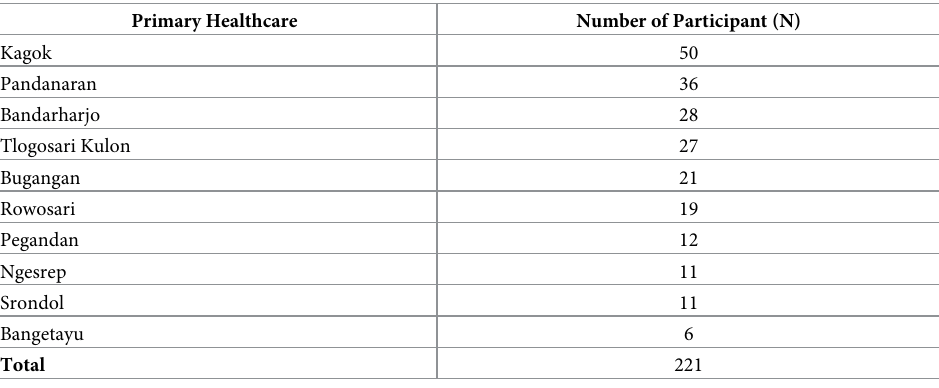
Table 1. The distribution of primary screening